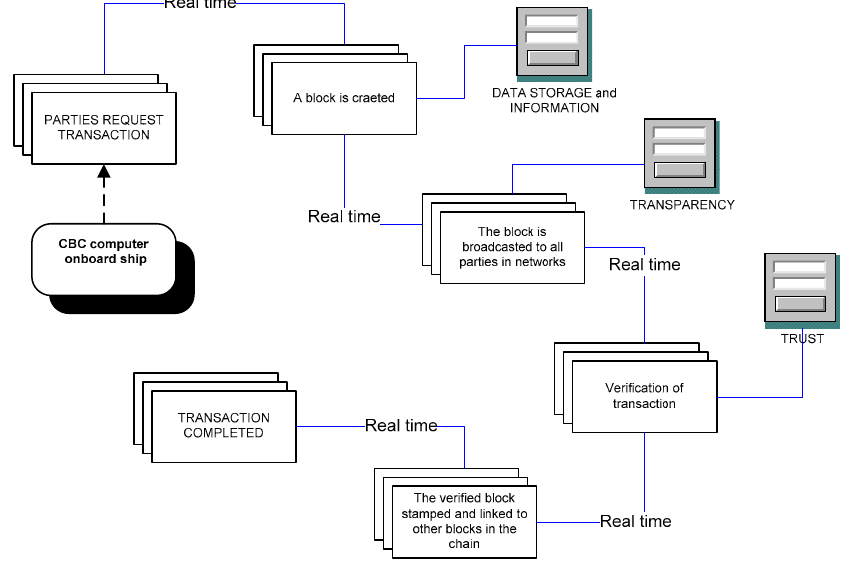
Figure 1. Key features of the blockchain (BC). Source: Authors.